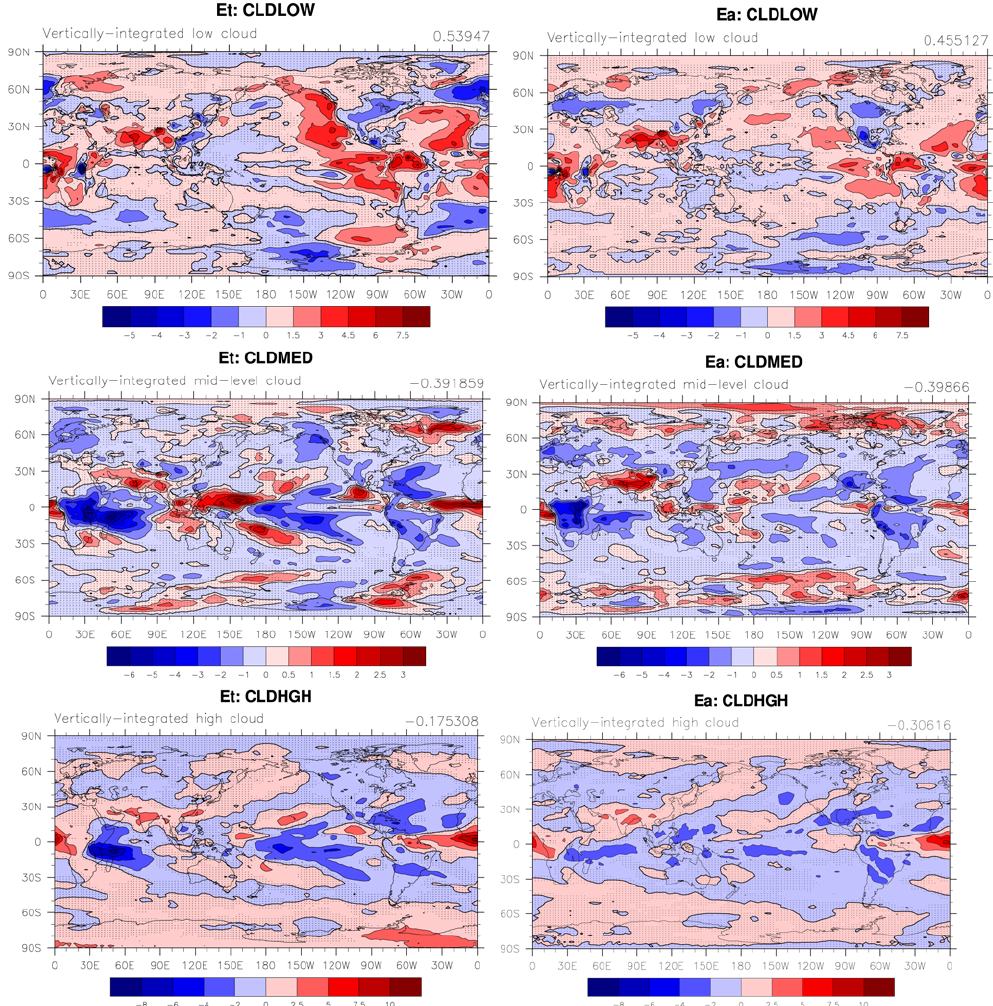
Fig. 12. Changes in annual mean low-, mid-, and high-level cloud coverage